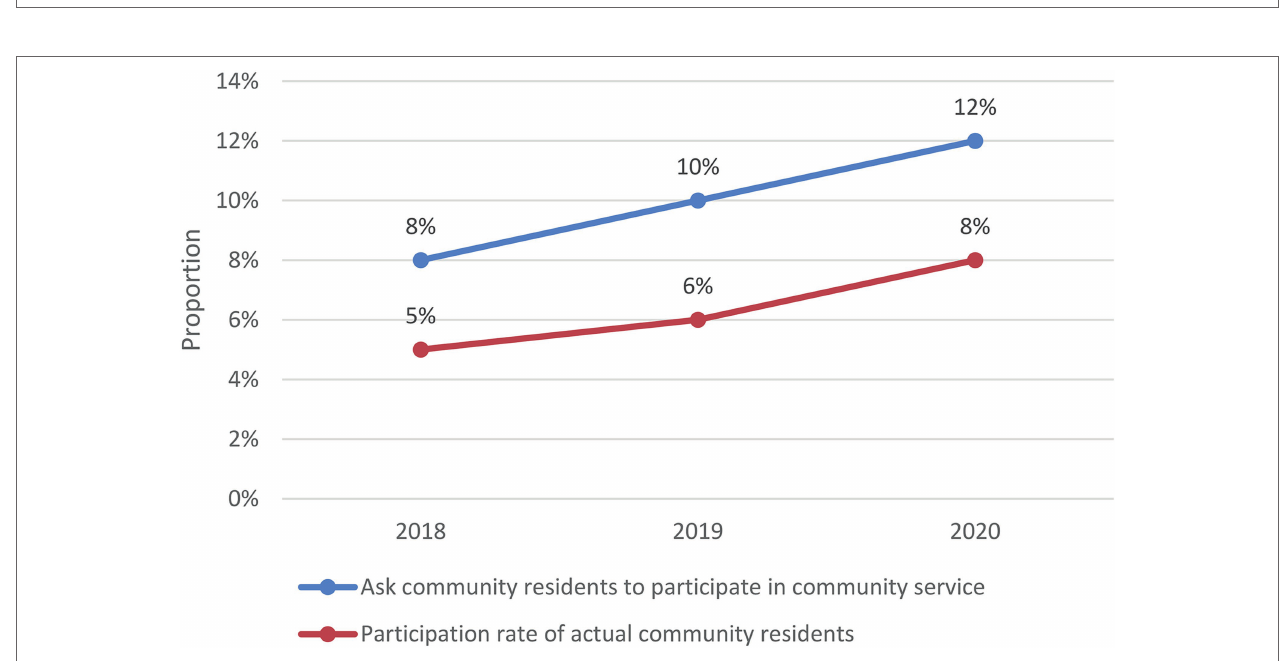
FIGURE 8 | Participation of community residents.